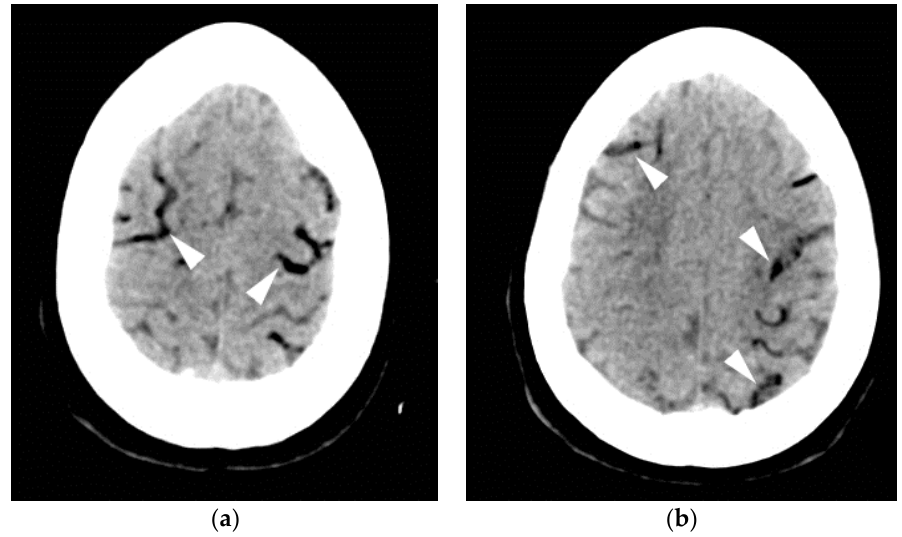
Figure 8. A 27 ‐ year ‐ old woman with encephalitis who suffered a respiratory arrest. Two images from axial CT brain ( a , b ) performed shortly afterward revealed extensive, serpiginous hypodensity in the sulcal distribution overlying the cerebral hemispheres bilaterally (arrowheads), representing intravascular air embolization. The patient made a full recovery with prompt 100% oxygen administration and supportive measures